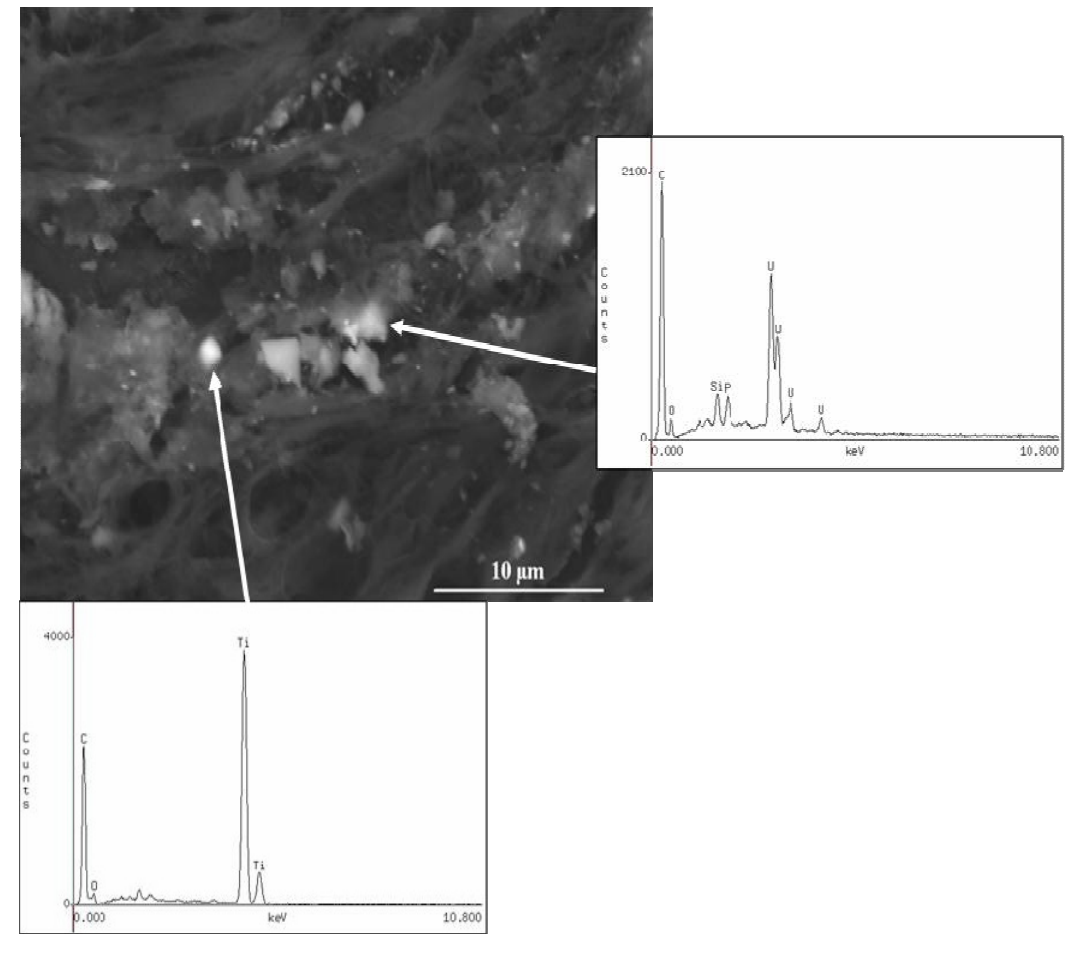
Figure 5. Case 2: Scanning electron microscopy (SEM) image of the DU fragment and energy-dispersive X-ray analysis (EDXA) of a region of tissue with granular black fragments demonstrating the presence of uranium and titanium. Depleted Uranium particles were measured in in the range of 0.8–1.69 µm. SEM original magnification